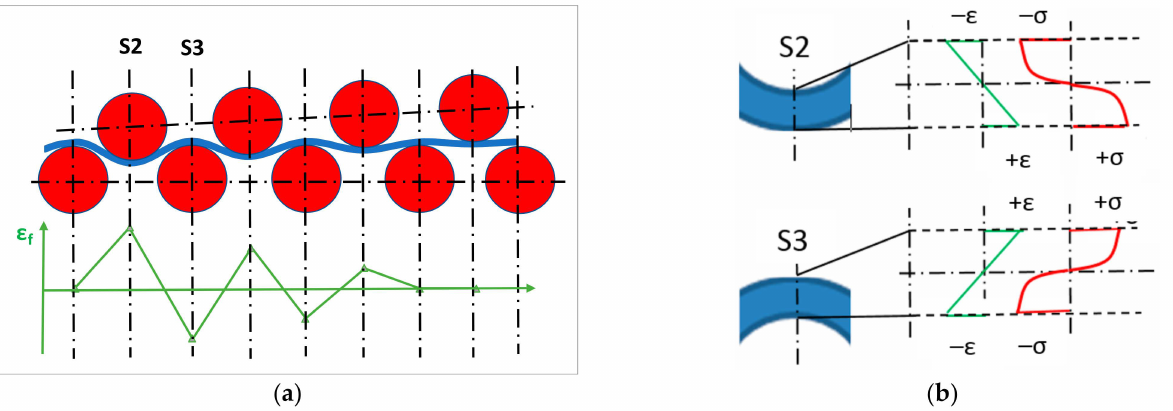
Figure 1. Illustration of roller levelling process; ( a ) simplified arrangement of rollers and sheet; ( b ) stress and strain distribution of two characteristic